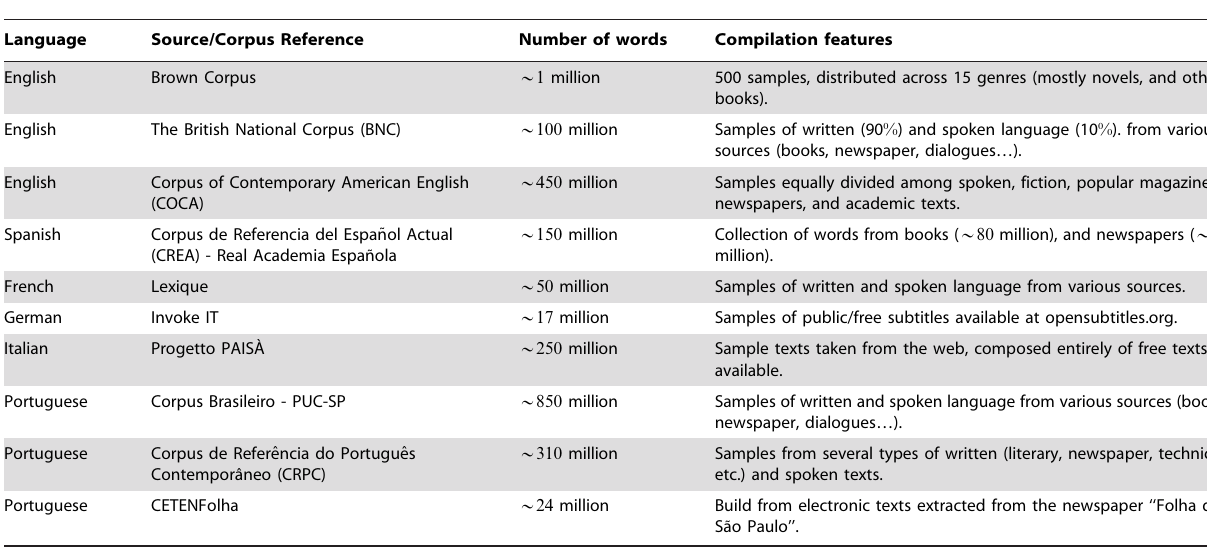
Table 2. Main features of some corpus in several languages.